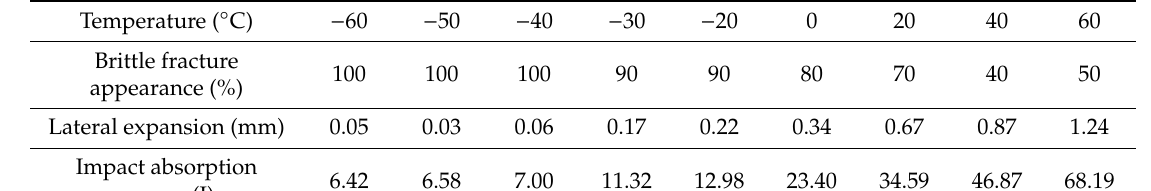
Table 4. Charpy impact test results.